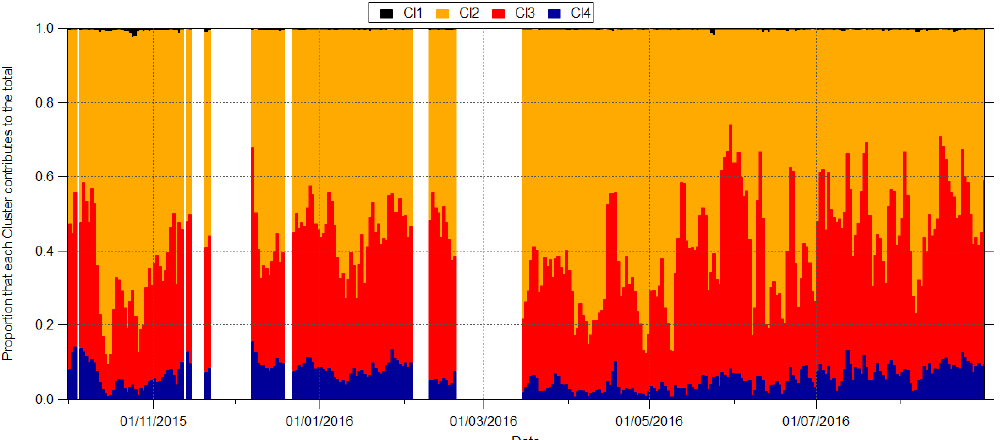
Figure 3. The proportion of the total fluorescent material that each cluster contributes over the 11-month monitoring campaign. Values are taken using 1d integrations of cluster concentrations between 0.8 and 10µm. Any gaps reflect missing